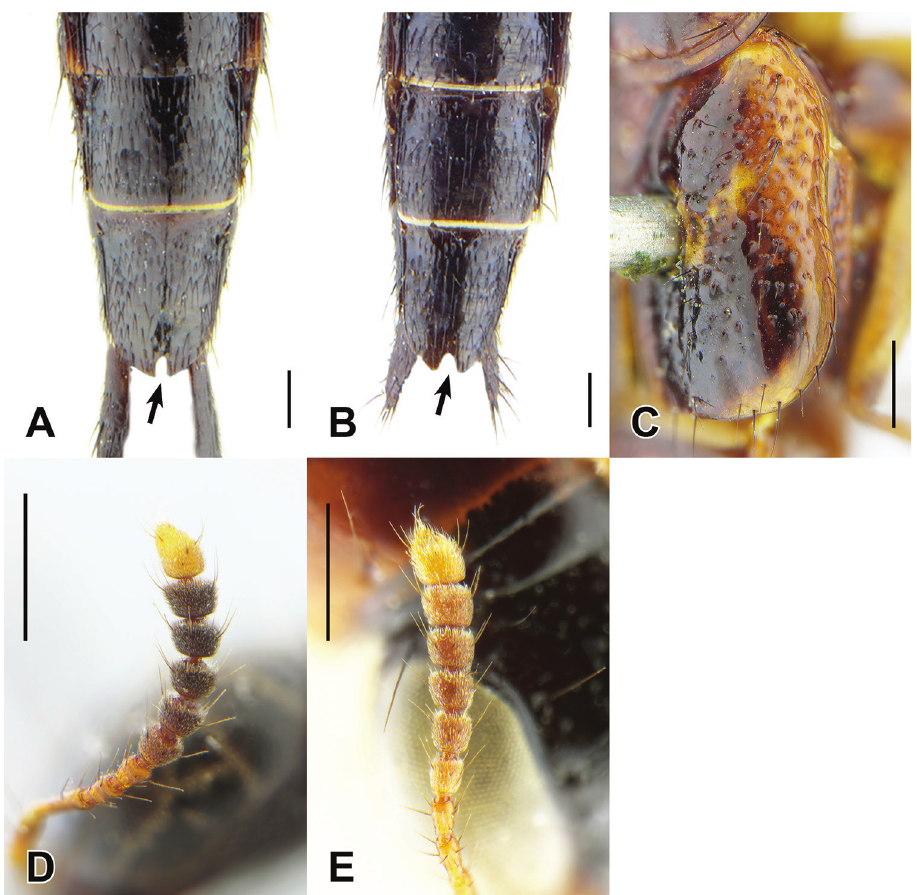
Figure 7. Female abdominal apex: B. schillhammeri Brunke ( A ) and B. flavus ( B ). Lateral view of elytron: B. mulayitensis Brunke ( C ). Antenna: Bolitogyrus mulayitensis Brunke ( D ) and B. feai Brunke ( E ). Scale bars: 0.5